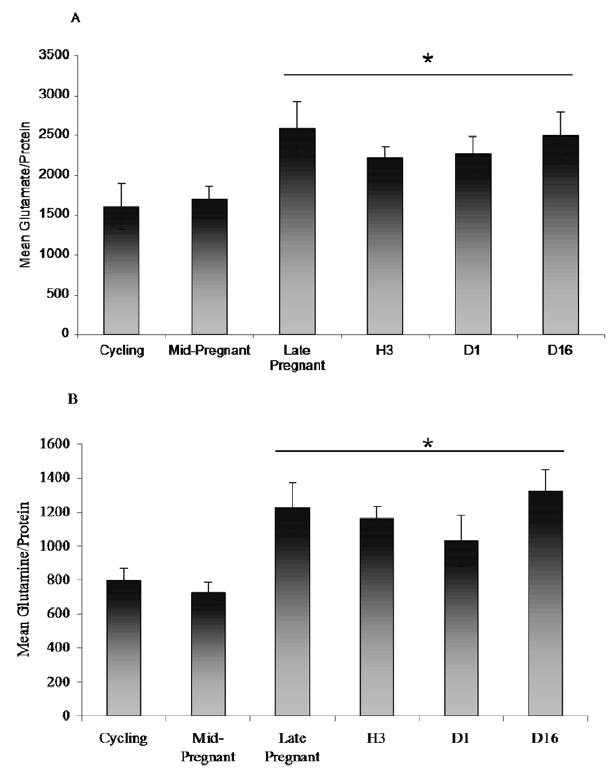
Figure 7. A representative blot image of GLT-1 and beta- tubulin from Cg2. Cycling (A), Mid-Pregnant (B), Late Pregnant (C), Hour 3 (D), Day 1 (E), and Day 16 postpartum (F). No significant differences were observed between groups.